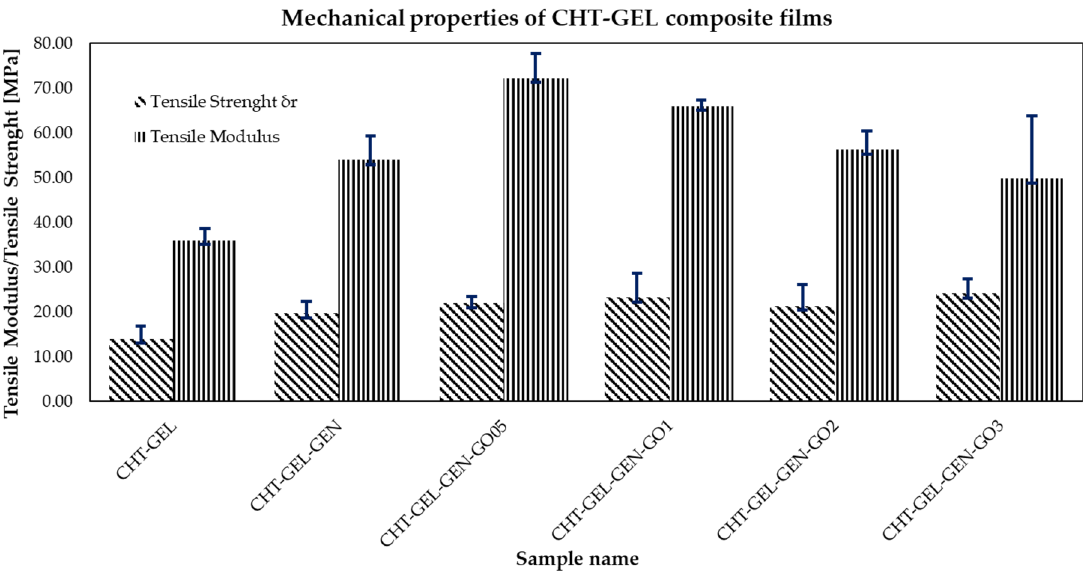
Figure 5. Tensile modulus and tensile strength of CHT-GEL and CHT-GEL-GEN-GO composite films.